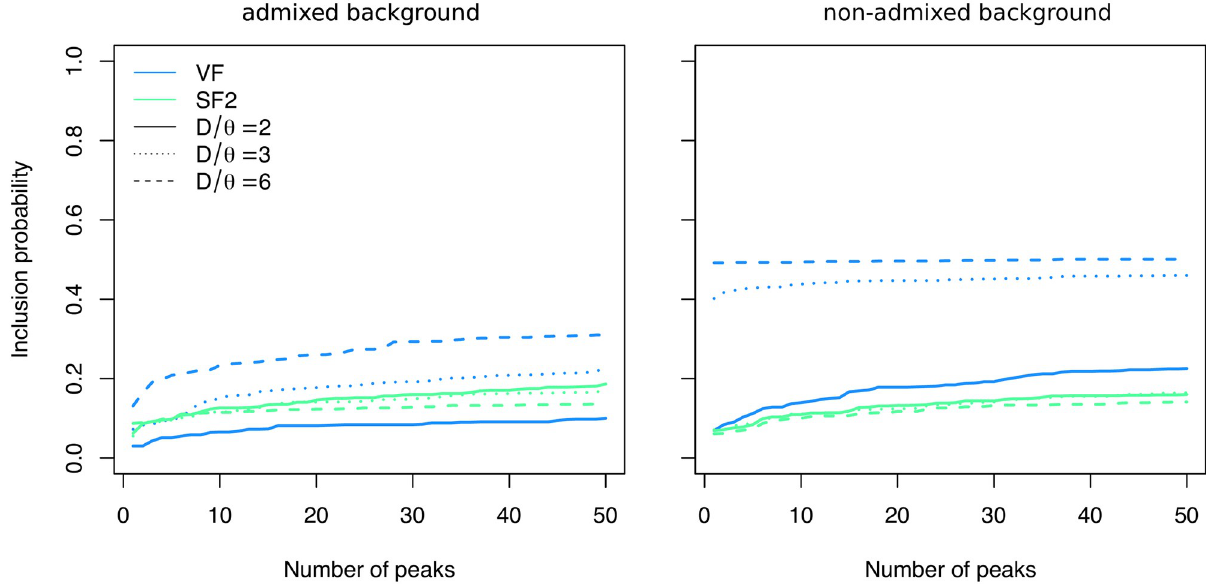
Fig 6. Detection probability with Out-of-Africa human demography. Probability of an introgression sweep event to be detected in a genome-scan analysis using VolcanoFinder (blue) or SweepFinder2 (green). The x-axis represents the number of false-positive peaks from the neutral data that score higher than the true-positive signal. The donor species diverged from the recipient species 615 kya (solid lines) 1.230 mya (dotted), or 2.460 mya (dashed), corresponding to D / θ = 2, 3, 6, respectively. Selection on the adaptive allele is strong (2 Ns = 1000). The left panel shows results with an admixed genomic background while the right panel shows results with the non-admixed background. Sample size n = 40 chromosomes and test sites were placed each 250 bp.